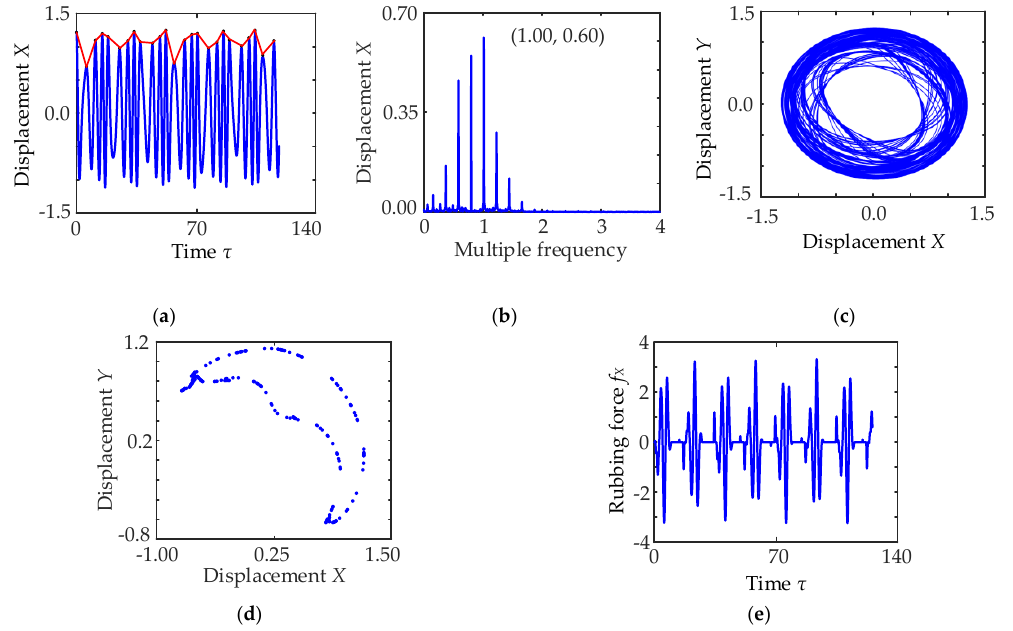
Figure 12. Rotor displacement when n = 11.5 krpm. ( a ) x - t ; ( b ) Amplitude spectrum; ( c ) Rotor trajectory; ( d ) Poincare mapping; ( e ) Rubbing force.